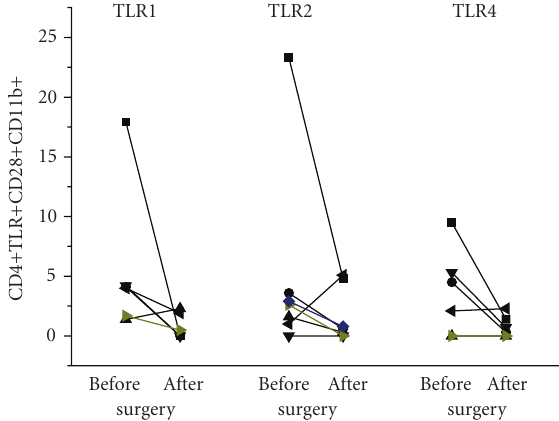
Figure 4: Presence of TLR positive cells in the peripheral blood of patients correlates with infection: CD4+CD28+CD11b+TLR1+, CD4+CD28+CD11b+TLR2, or CD4+CD28+CD11b+TLR4 was quantified by cytofluorometry at the day of surgery (before) or 6 to 8 days later (after), when the infection was resolved. Each symbol refers to an individual patient; the line connects the values before and after